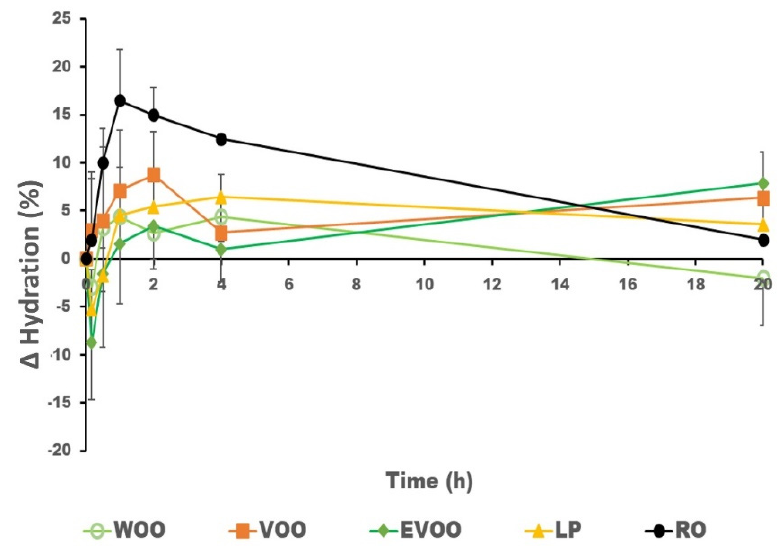
Figure 3. Mean results and variability ( n = 8) in the increase in hydration (%) at the site of administration during the first 20 h after application.